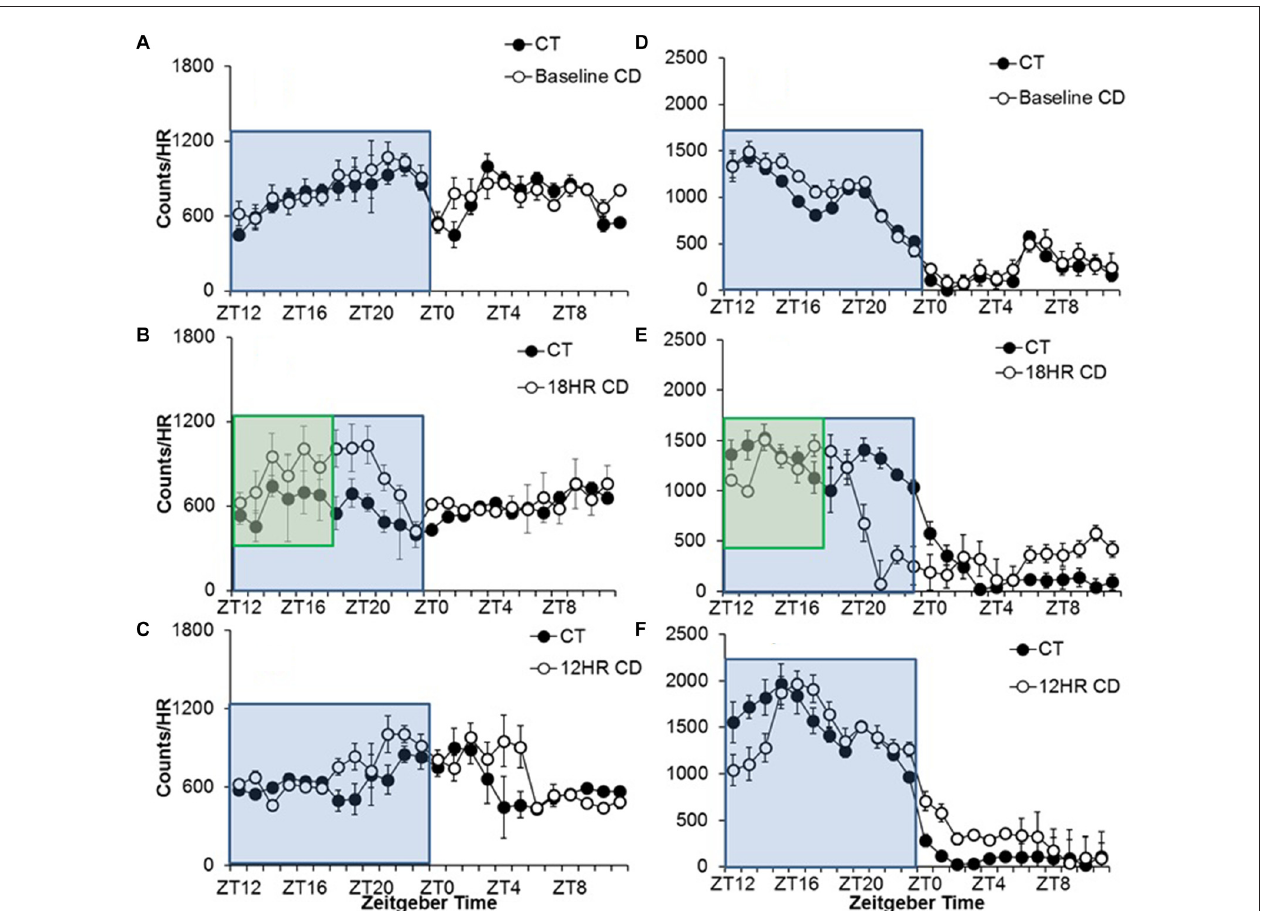
FIGURE 2 | Overall activity counts by hour in adolescent C57BL/6J mice during baseline alcohol access and 18HR environmental CD. There were no differences in patterns of baseline alcohol intake (A) , but mice in CD drank significantly more during the 6 h after lights-on in the 18HR photoperiod (B) and extended their alcohol intake further into the light cycle in the 12HR photoperiod (C) . There were no differences in baseline wheel-running (D) , and mice in CD only showed significant activity in the dark (active phase; E,F ; blue boxes indicate normal 12HR dark; green boxes indicate 6HR dark phase for mice in CD; data indicate the mean ± SEM for n =